Question: Does the plotted quantity increase or decrease?
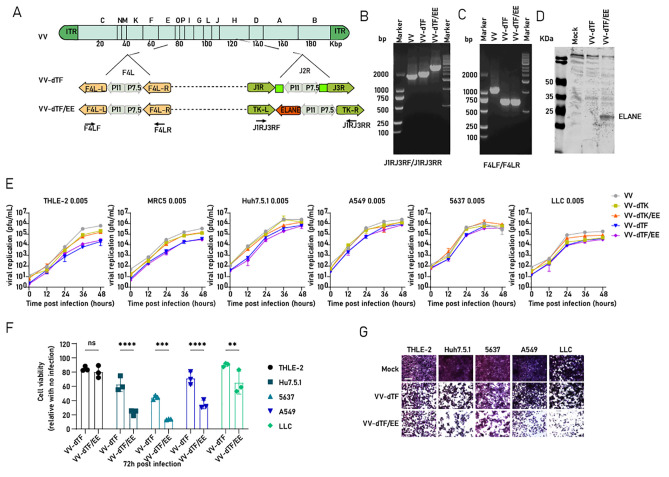
Answer: increasing